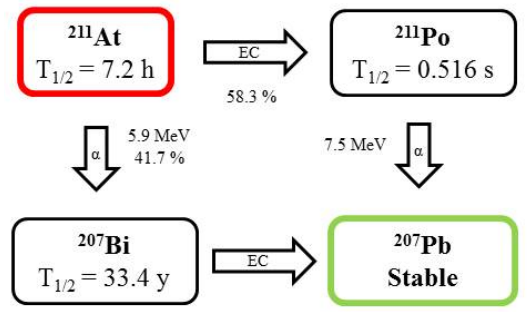
Figure 2. Decay scheme of 211 At.